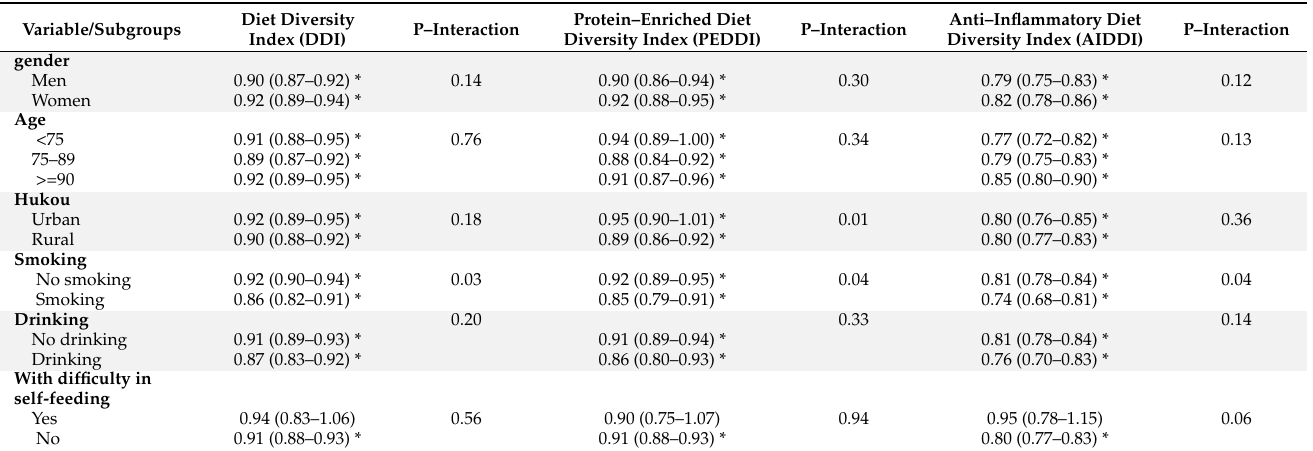
Table 3. Associations of types of Dietary Diversity, Dietary Pattern with depressive symptoms among